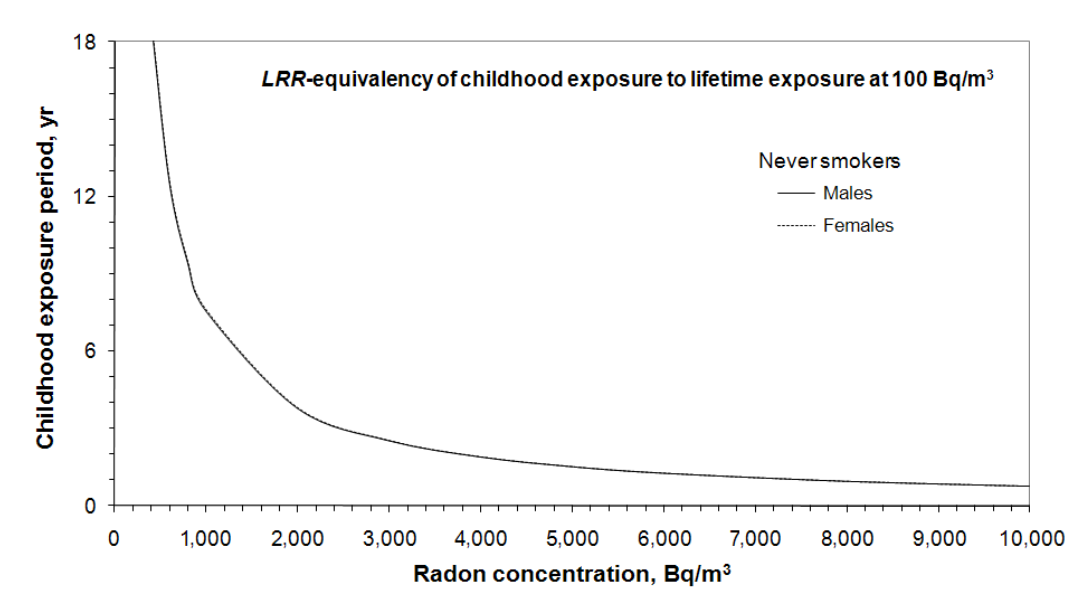
Figure 4. LRR -equivalency of short period high radon exposure in childhood to lifetime exposure to 100 Bq/m 3 for never smokers.